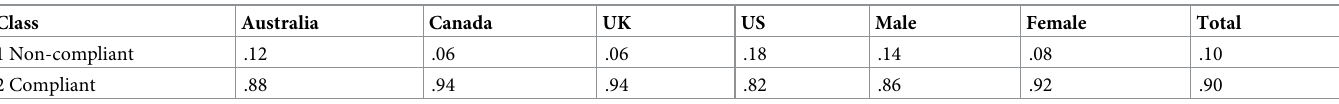
Table 4. Proportion of individuals in LPA classes from each country and gender (N =